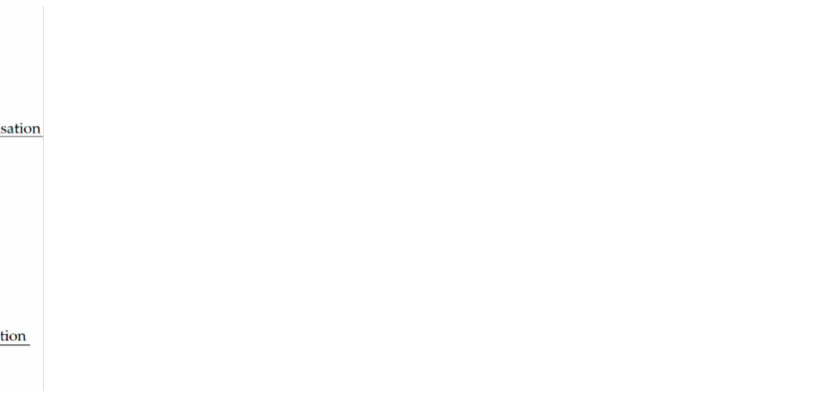
Figure 5. The heat pipe with fins. According to the reports of Mardiana-Idayu and Riffat [78], heat pipes are the most effective solution for heat recovery for passive